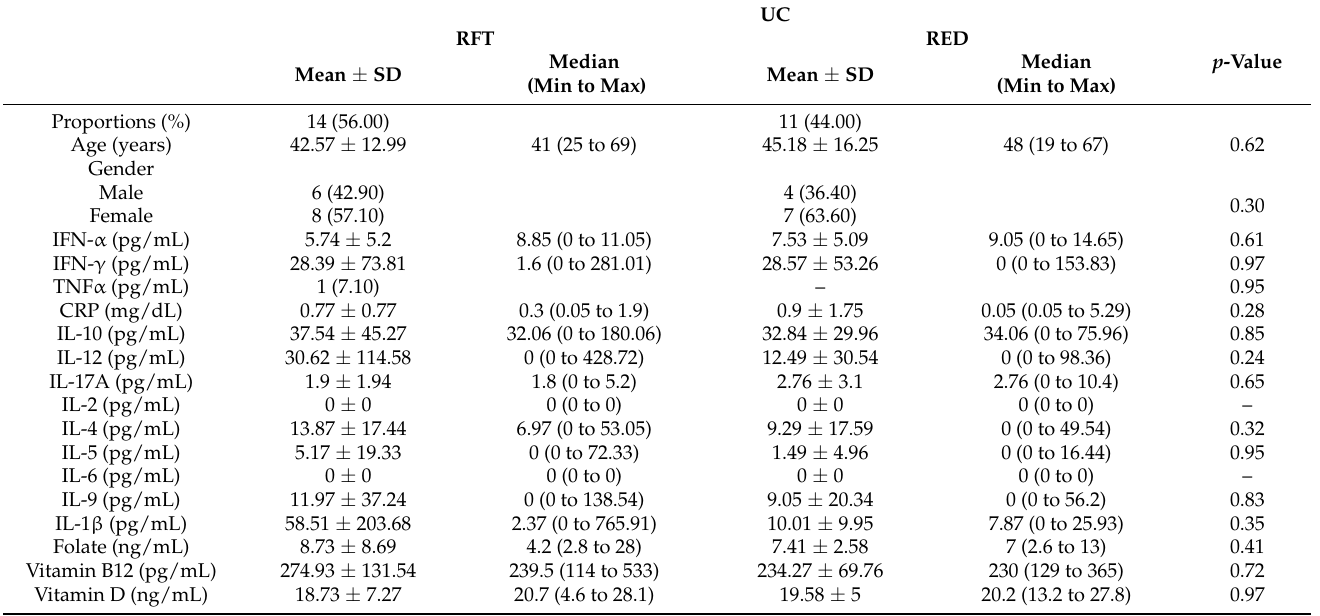
Figure 2. Serological biomarkers that were different between the red fruit tea (RFT) and purple corn extract (RED) groups in CD patients at T3 (N: 22). Table 4. Description of the whole sample at follow-up observation (T3) in CD patients, according to the type of treatment. (N: 22). Statistically significant differences ( p -value ≤ 0.05 ) are underlined in bold.